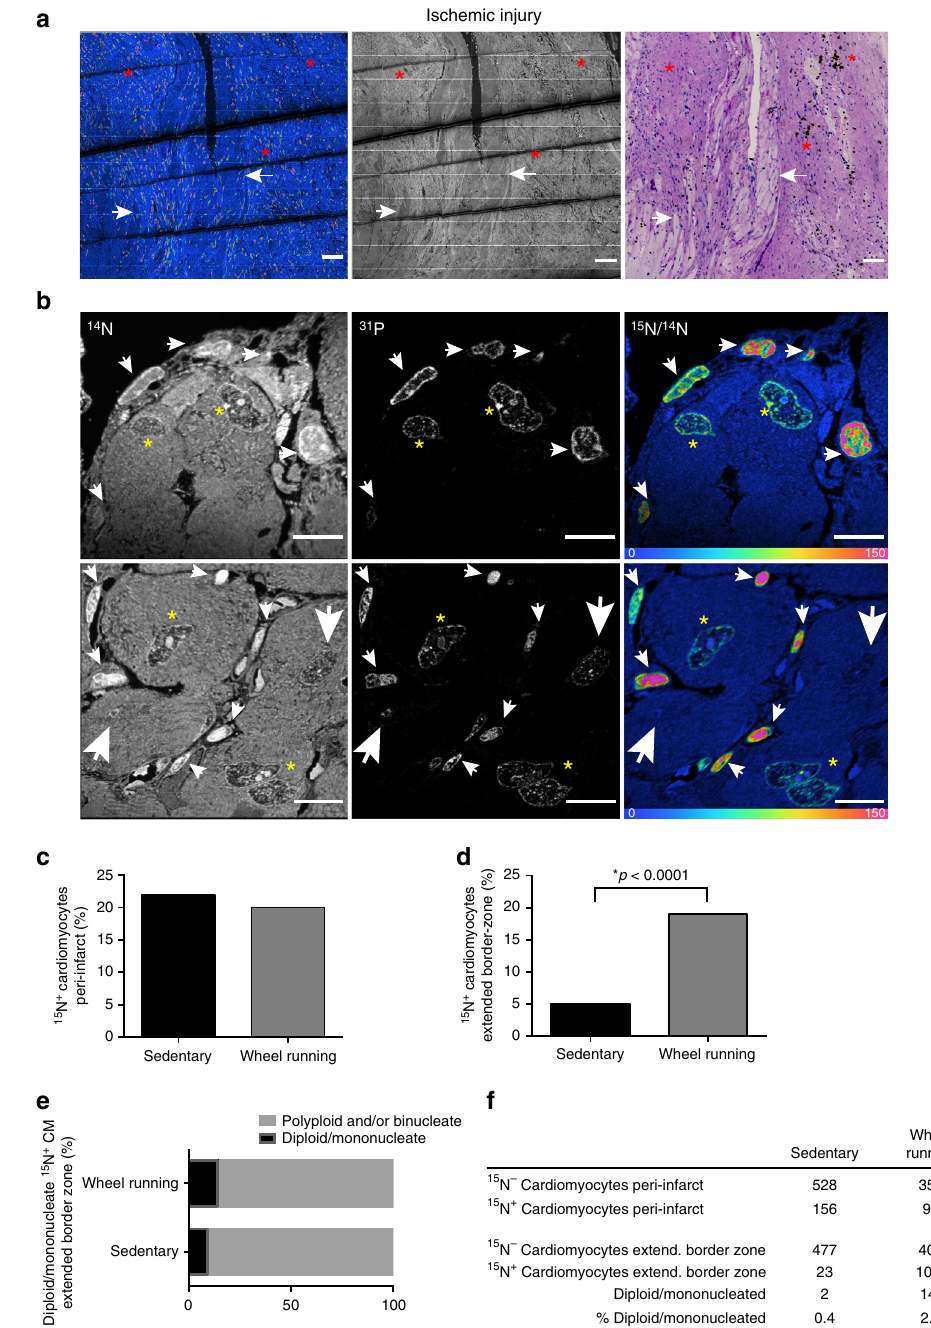
Fig. 3 Exercise induces cardiomyogenesis in an extended MI border zone. Mice were subjected to experimental myocardial infarction (MI) by ligation of the left anterior descending artery and exposed to exercise or sedentary activity for 8 weeks, starting 24h post surgery. Subcutaneous osmotic pumps were implanted to continuously label mice with 15 N-thymidine for eight weeks following surgery. a Myocardial ischemic injury results in extensive DNA synthesis in the peri-infarct area. 15 N: 14 N hue-saturation-intensity image (HSI mosaic) (left) demonstrates 15 N + cells while 14 N mass image (center) and PAS staining (right) demonstrate presence of cardiomyocytes (white arrow) and a visible scar/ fi brosis (dark purple PAS staining, red asterisks). The HSI mosaic scale ranges from blue, where the ratio is equivalent to natural ratio (0% above natural ratio (enrichment over natural ratio)), to red, where the ratio is 150% above natural ratio. Scale bar = 60 μ m. b Representative magni fi cations from the peri-infarct and extended border zone areas. Mass 14 N image (top left, bottom left), mass 31 P image (center, top, and bottom), and the HSI mosaic (top right, bottom right) demonstrate nuclear 15 N labeling of cardiomyocytes undergoing DNA synthesis (yellow asterisk), non-labeled-cardiomyocytes (large white arrows), and 15 N-labeled non-cardiomyocytes (small white arrows). Scale bar = 56 μ m. 15 N-thymidine has exclusively labeled the nucleus while the cytoplasm is at the natural abundance level. c Percentage of 15 N + cardiomyocyte nuclei after MI with or without exercise in the peri-infarct region (sedentary:exercise = 22.76%:20.43%; >400 cells from three mice per group were counted, p = ns, Fisher ’ s exact test) and d the extended border zone of the infarct (sedentary: exercise = 5.29%:19.09%; >500 cells from three mice per group were counted, p <0.0001, Fisher ’ s exact test). e Bar graph showing the frequency of mononucleate/diploid vs. polyploid and/or multinucleate 15 N-thymidine-labeled cardiomyocytes from each group. f Contingency table showing the absolute numbers of 15 N-labeled mononucleate/ diploid cells of total counted cardiomyocytes from each group (sedentary:exercise = 0.4%:2.7%, p = 0.004, Fisher ’ s exact test, OR = 6.931, CI 1.87 –